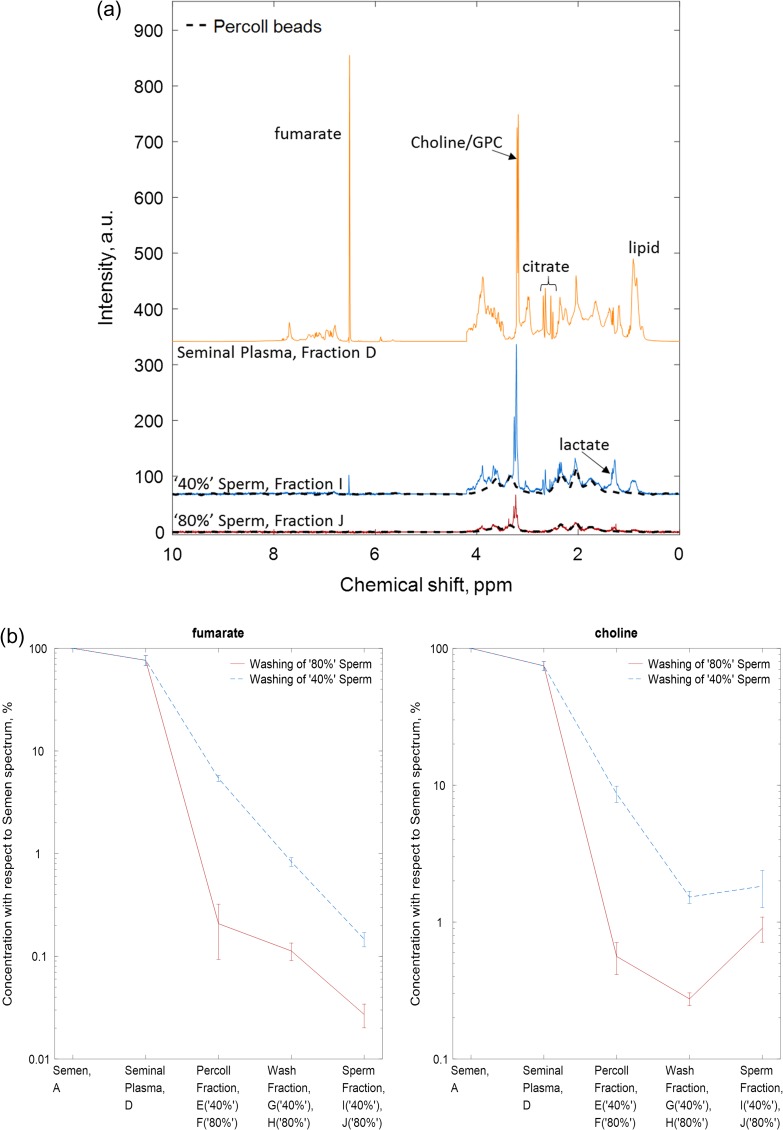
(a) Representative 1H MRS spectra derived from fumarate (200 mM) spiked donor semen after Percoll density centrifugation (Experiment 2); 80% sperm spectrum (Fraction J); 40% sperm spectrum (Fraction I); seminal plasma (Fraction D) spectrum recovered from supernatant after washing. 1H spectrum of Percoll beads colloidal solution (black dashed line) overlaid onto 80% and 40% sperm spectra. GPC, glycerophosphocholine. (b) The integrals for fumarate (left) and choline (right) from each of the fractions collected during the washing procedure, Fractions A, D–J. The fumarate and choline integrals were normalized with respect to their initial value from the semen spectrum. 80% sperm washings (red solid line), 40% sperm washings (dashed blue line) show the concentration the respective metabolite at each stage of the washing protocol. See Fig. 1 for fraction identification.